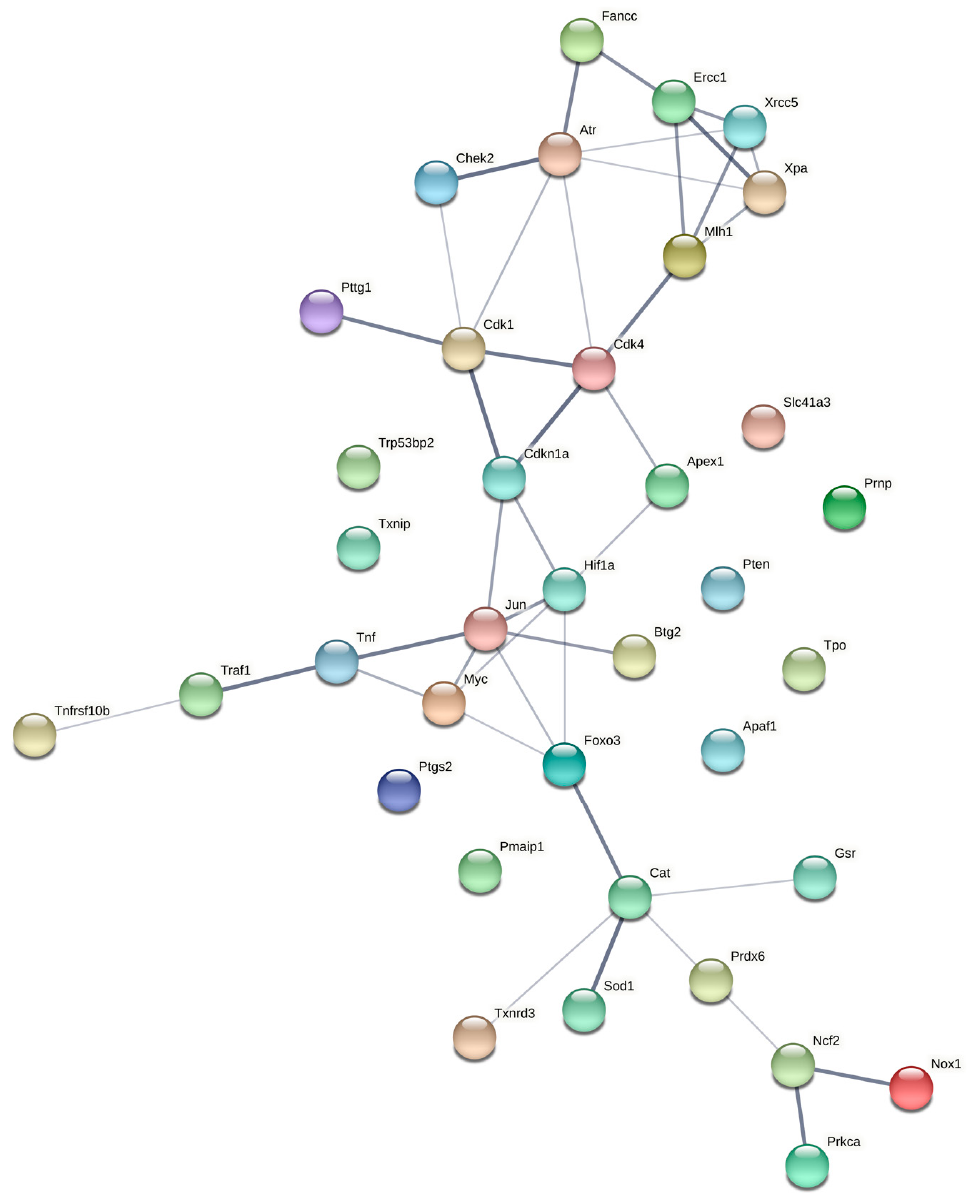
Figure 3. Predicted molecular interactions among DEGs from an oxidative stress PCR Array and p53 Signaling Pathway PCR Array using String Db (Refer to the Methods section for details on analysis). Thicker lines connecting genes represent greater confidence in molecular interactions.